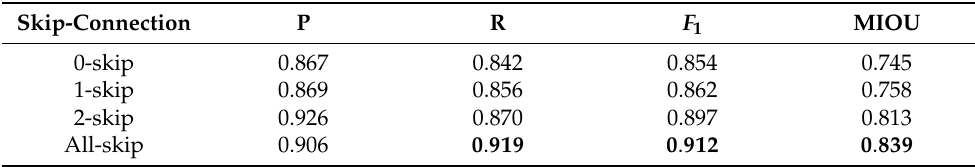
Table 4. Experimental results of different number of skips.